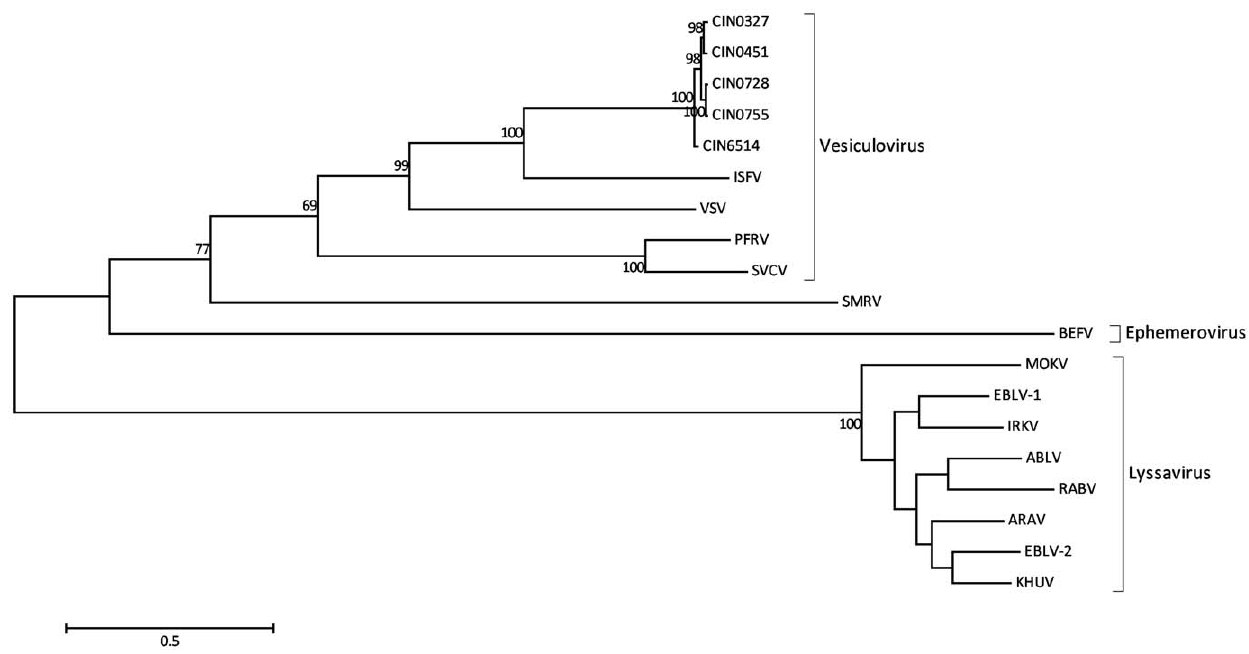
Figure 1. Phylogenetic tree of the whole genomes of the CHPV isolates and other rhabdoviruses using the Maximum likelihood method as implemented in MEGA. v.5.05. Bootstrap values greater than 60% are indicated at the appropriate nodes. Scale bar indicates number of nucleotide substitutions per site. Abbreviations: CHPV (Chandipura virus; acc nos. GU212856.1-58.1 [CIN0327, CIN0451, CIN0751], GU190711.1 [CIN0728], CIN6514 [deduced 1965 CHPV sequence]); ISFV (Isfahan virus; acc. no. AJ810084.2); VSV (vesicular stomatitis virus; acc. no. NC_001560.1); PFRV (pike fry rhabdovirus; acc. no. FJ872827.1); SVCV (spring viraemia of carp virus; acc. no. DQ097384.2); SMRV (Scopthalmus maximus rhabdovirus; acc. no. HQ003891.1); BEFV (Bovine Ephemeral fever virus; acc. no. AF234533.1); MOKV (Mokola virus; acc. no. NC_006429.1); EBLV-1 (European bat lyssavirus-1; acc. no. EU293112.1); IRKV (Irkut virus; acc. no. EF614260.1); ABLV (Australian bat lyssavirus; acc. no. AF418014.1); RABV (rabies virus; acc. no. GQ918139); ARAV (Aravan virus; acc. no. EF614259.1); EBLV-2 (European bat lyssavirus-2; acc. no. NC_009528.1); KHUV (Khujand virus; acc. no. EF614261.1).